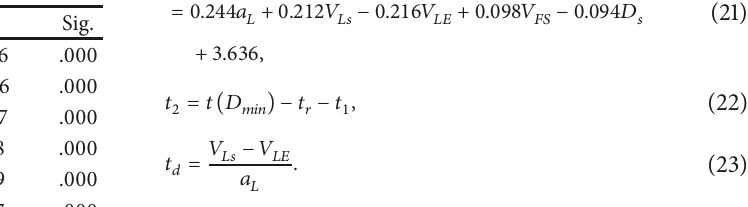
Table 2: Regression results of 𝑡 𝑟 , t